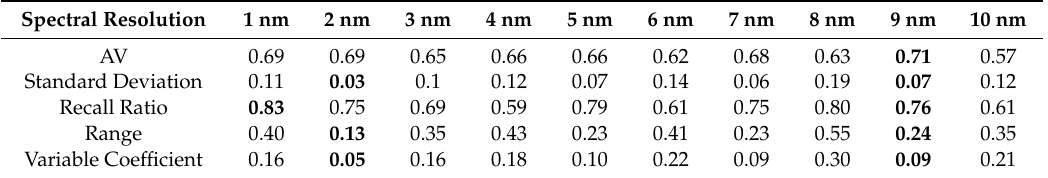
Figure 8. Optimal accuracies ( a ) and corresponding boxplots ( b ) for diagnosing Pb pollution in di ff erent resolutions. Table 6. Statistical results of Cd-Pb comprehensive diagnosis after selecting band